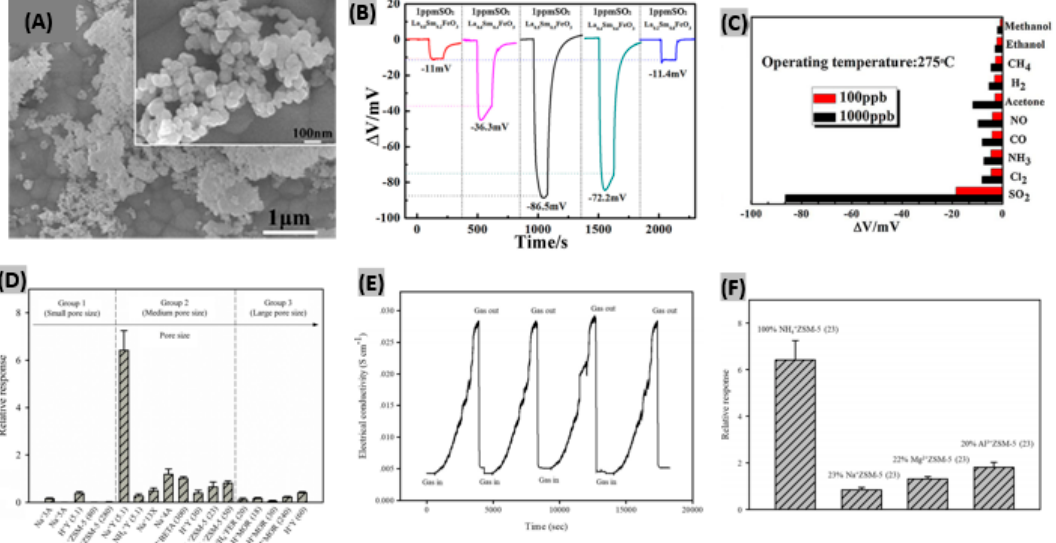
Figure 10. ( A ) SEM image of powdered La 0.5 Sm 0.5 FeO 3 , inset shows higher magnified image. ( B )